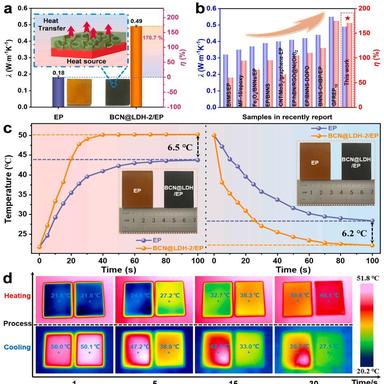
(a) Thermal conductivity (λ) of pure EP and BCN@LDH-2/EP (10 wt%). Schematic illustration of heat transport (inset a). (b) Comparison of thermal conductivity and thermal conductivity improvement efficiency (η) of BCN@LDH/EP with other epoxy resin-based composites for the same filling. (c)The time-dependent curves of the upper surface temperature and (d) Infrared thermal images of EP and BCN@LDH-2/EP during heating and cooling.